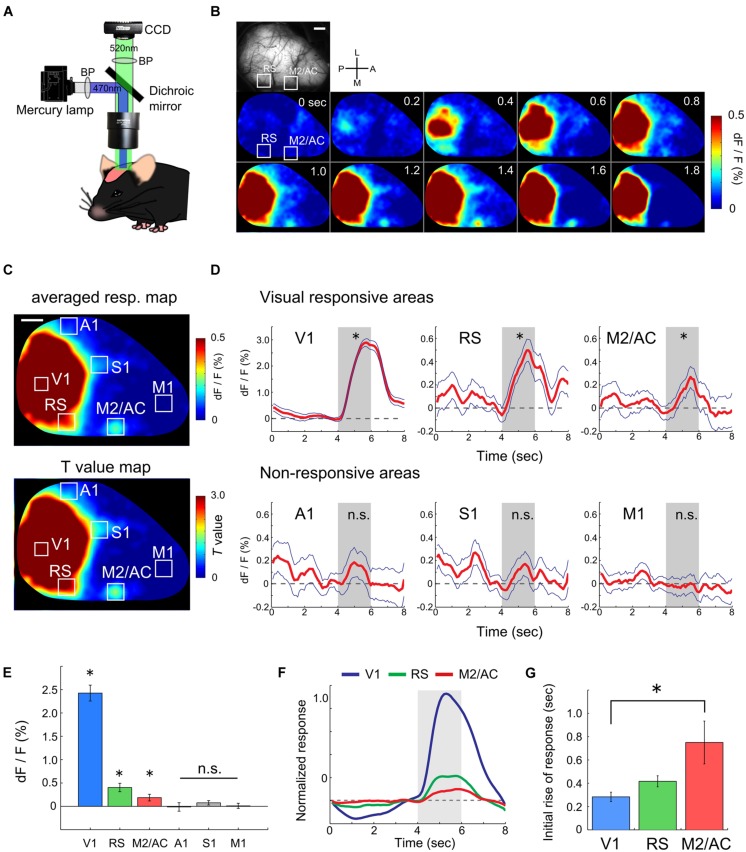
Functional mapping of visual responsive areas. (A) Experimental setup of wide-field Ca2+ imaging. (B) An example of a visual response in an entire hemisphere. (Top-left) Shows field of view (FOV). White two squares indicate regions of the RS and M2/AC. From upper left to lower right, sequential Ca2+ imaging snapshots from stimulus onset are presented (frame rate at 200 ms). (C) Representative response map averaged across 50 trials (top) and corresponding T-value map (bottom). Same animal as in (B). (D) Representative average time courses of visually responsive (upper) and non-responsive areas (bottom). Each time course was obtained from regions of interests (ROIs) located in each area. ROI size was 260 μm × 260 μm which smaller than the white squares in (B) and (C). Blue line: SE. Dashed line: baseline of Ca2+ signal. Gray shade: stimulus period. (E) Averaged signal change (dF/F) across animals (n = 6 mice). (F) Averaged time courses of the visual response in V1, RS, and M2/AC across animals (n = 6 mice). (G) Timing of the initial rises of the visual response. Error bar: SE, ∗p < 0.05, n.s.: non-significant, by Student’s t-test in (D) and (E), and by ANOVA and post hoc Tukey’s HSD test in (G). Scale bars in (B) and (C): 1 mm.